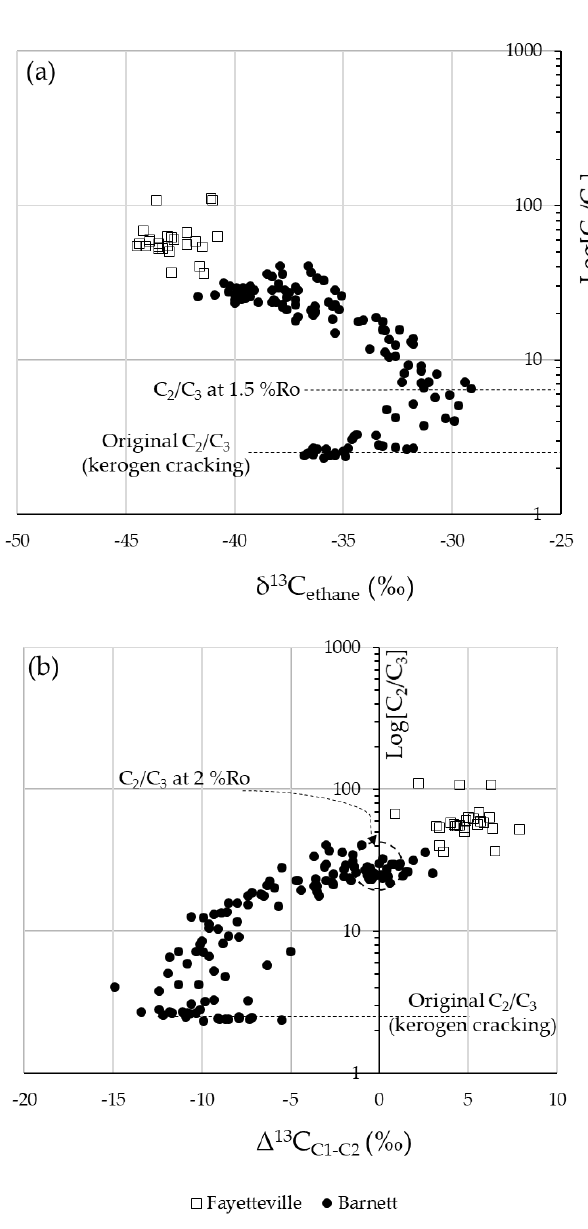
Figure 1. The relationships between the C 2 /C 3 ratio and ( a ) the δ 13 C of ethane, and ( b ) the ∆ 13 C C1-C2 difference; for samples from the Barnett and Fayetteville shales.